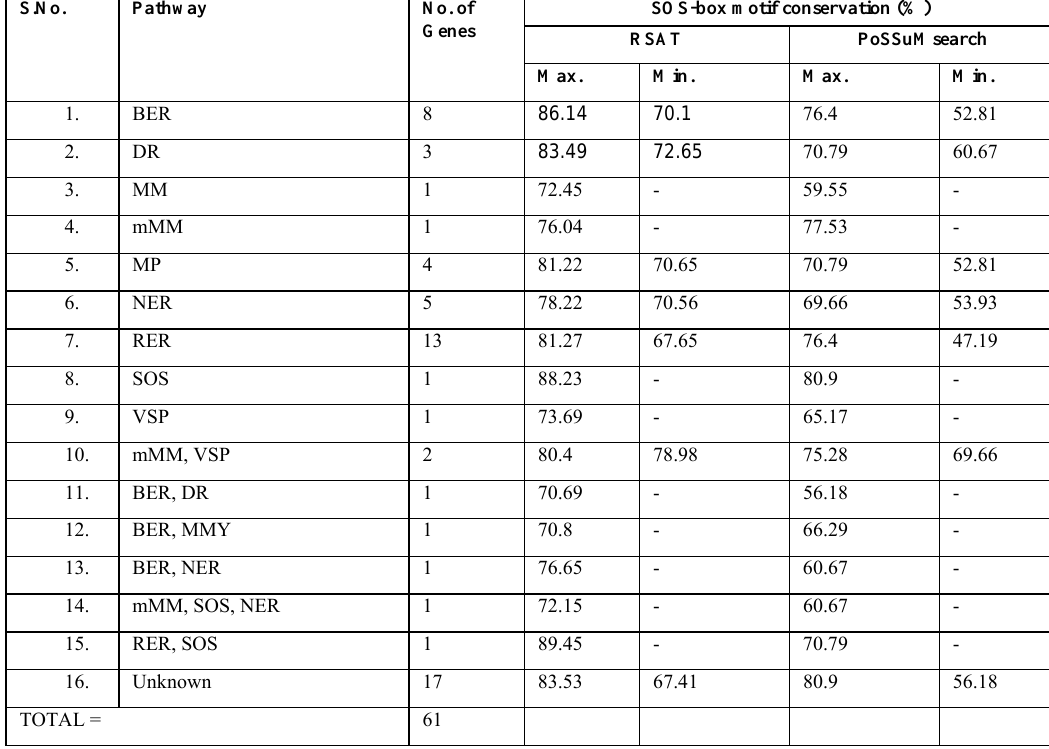
Table 4: Comparison of SOS-box motif conservation (in %) predicted through both RSAT & PoSSuMsearch programs in D. radiodurans genes related to replication, repair and recombination